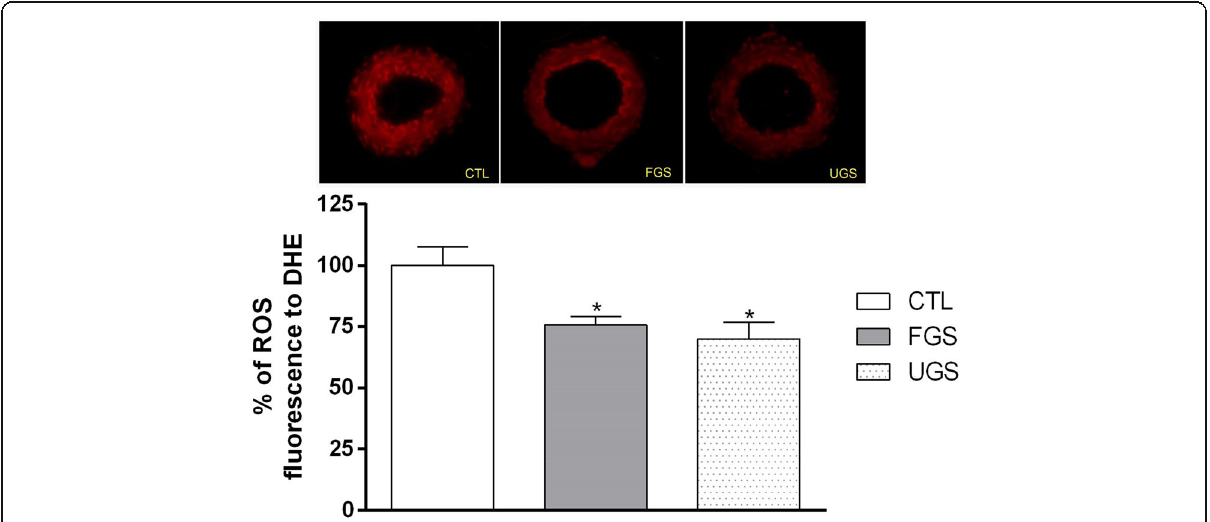
Fig. 3 ROS measurement in intact mesenteric arteries exposed to different experimental conditions. Reduced effects of redox-sensitive fluorescence dye to DHE in normotensive small mesenteric artery sections exposed to vehicle (PBS), fermented (FGS) or unfermented (UGS) grape skin extracts. Data are expressed as mean ± SEM of 4 experiments. * significant when compared to controls (CTL), P <